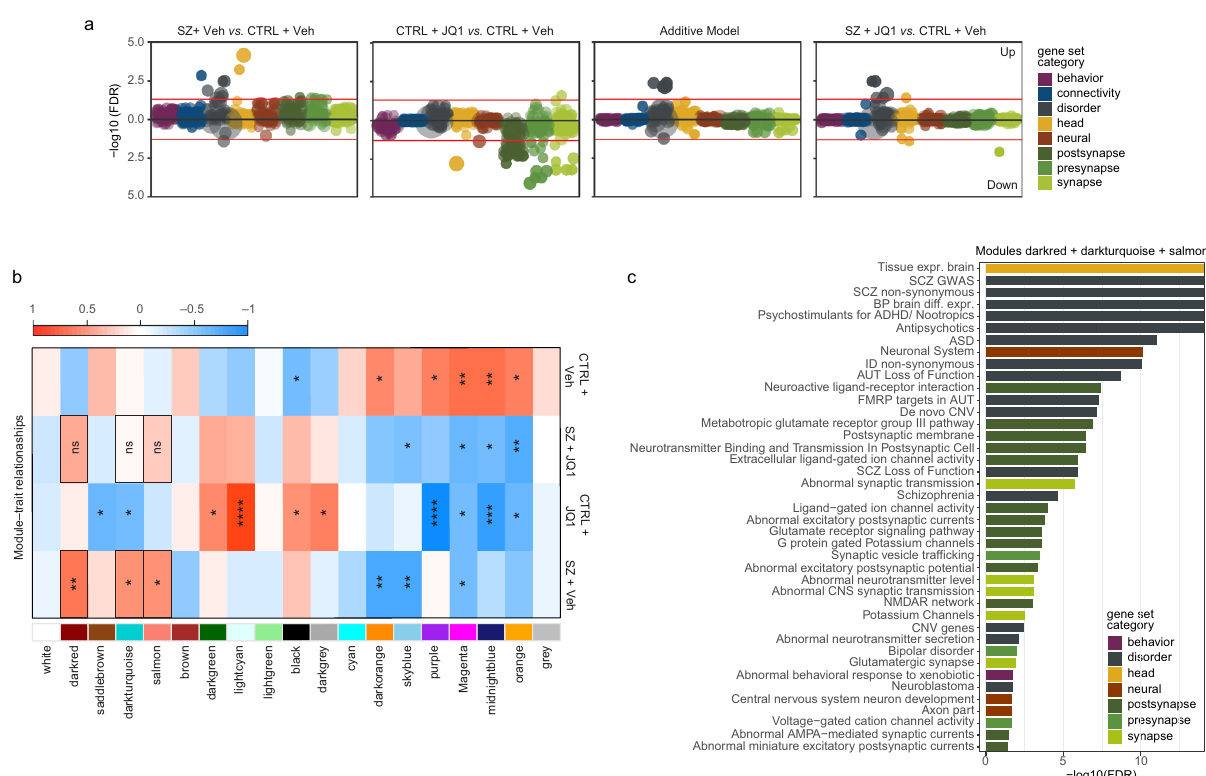
Fig. 3 RNA-seq of SZ, control (CTRL) and JQ1-treated hiPSC neurons. a Competitive gene-set enrichment analysis (camera) of differential expression contrasts from the current study, based on 698 curated neural gene sets 19, 20 , strati fi ed by eight categories. b Sample trait — module association heatmap. Columns correspond to module eigengenes, rows to sample groups. Cell labels denote weighted Pearson correlation and Student asymptotic p -value of corresponding module and group ( n = 4 ctrl + vehicle samples, n = 3 SZ + vehicle samples, n = 4 Ctrl + JQ samples and n = 3 SZ + JQ samples). * p ≤ 0.05, ** p ≤ 0.01, **** p ≤ 0.0001. c Over-representation analysis (ORA), using a hypergeometric test, of 698 curated gene sets and ranked genes in three modules, Darturquoise, Salmon, and Darkred. These showed highest association with the SZ samples ’ transcriptional signature and reduced correlation with SZ + JQ samples. Only gene sets with enrichment FDR < 5% are